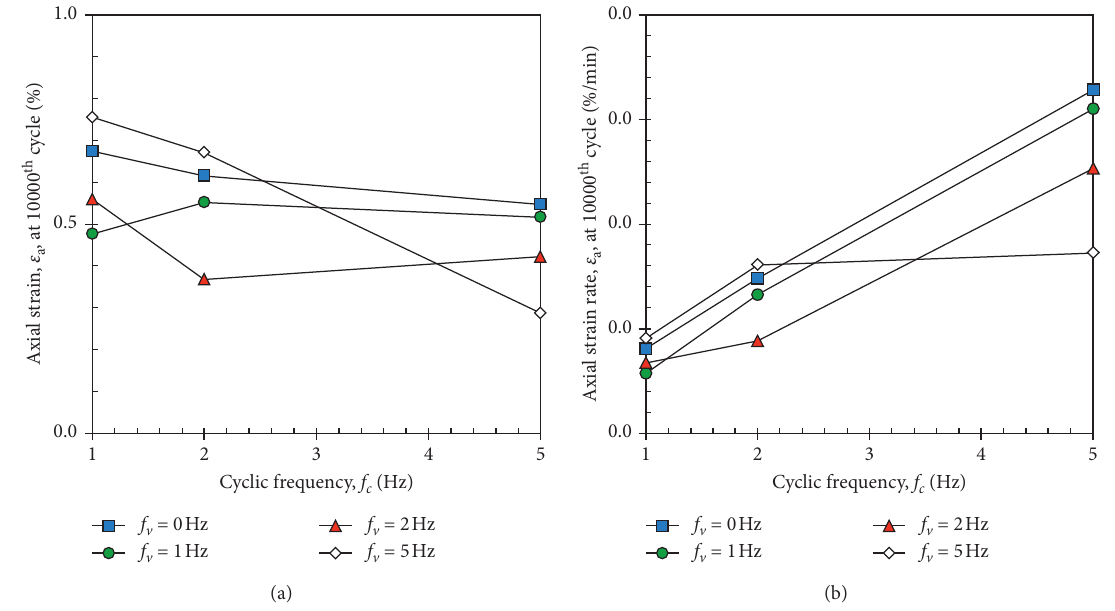
Figure 12: Variation of (a) ε